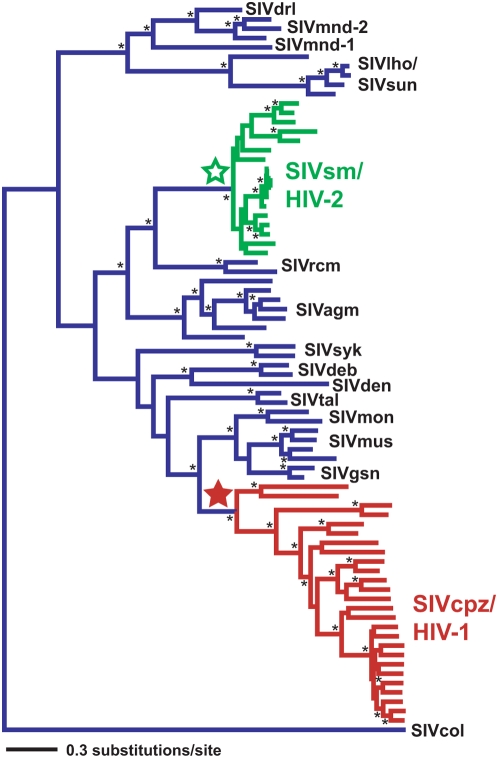
Maximum likelihood phylogeny of SIV/HIV env locus.SIVsm/HIV-2 lineages are green and their MRCA is designated with an open green star. SIVcpz/HIV-1 lineages are red and their MRCA is designated with a closed red star. All other SIV lineages are blue. Tree is midpoint rooted. Nodes with bootstrap support >80% are indicated with an asterisk.